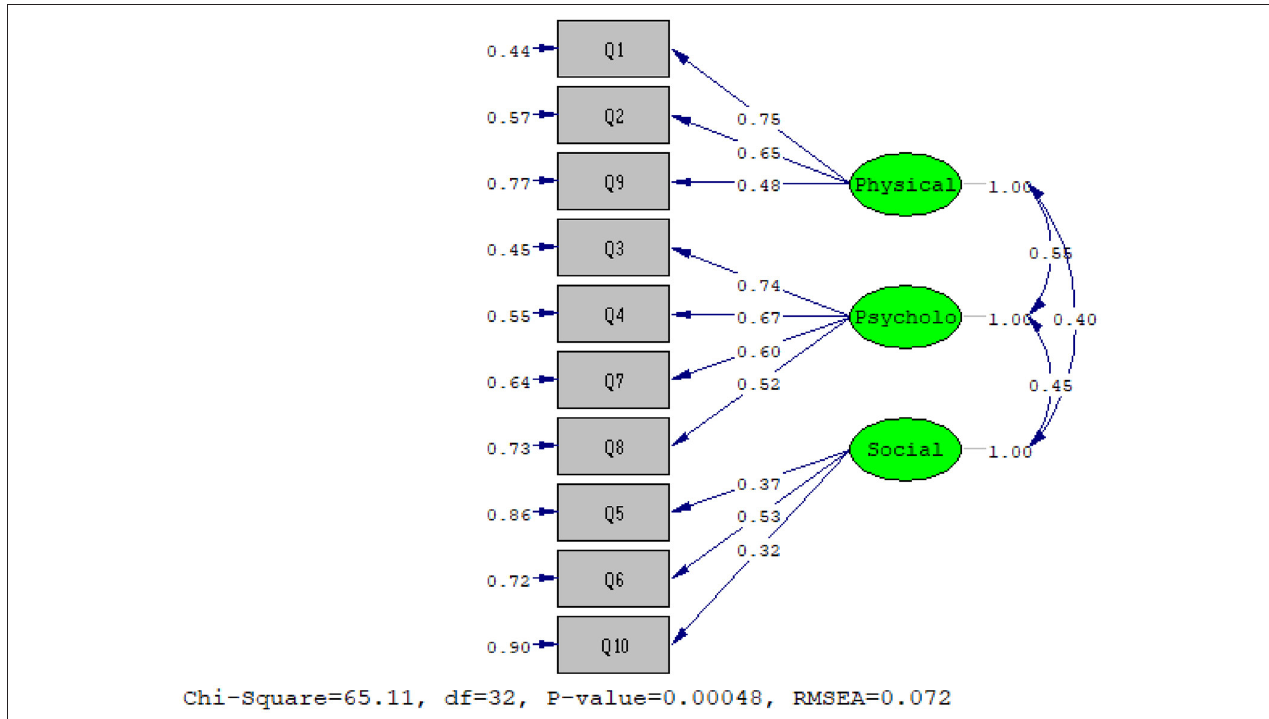
FIGURE 1 | The final structure of the